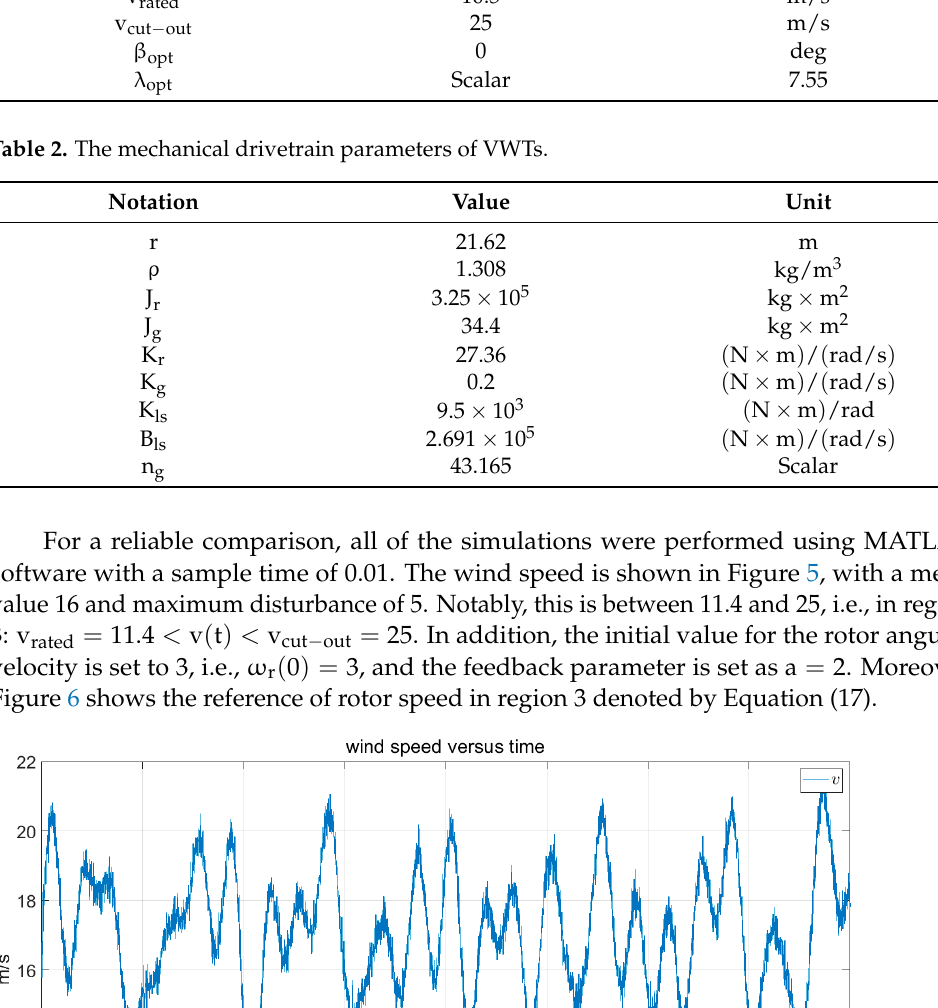
Table 2. The mechanical drivetrain parameters of VWTs.